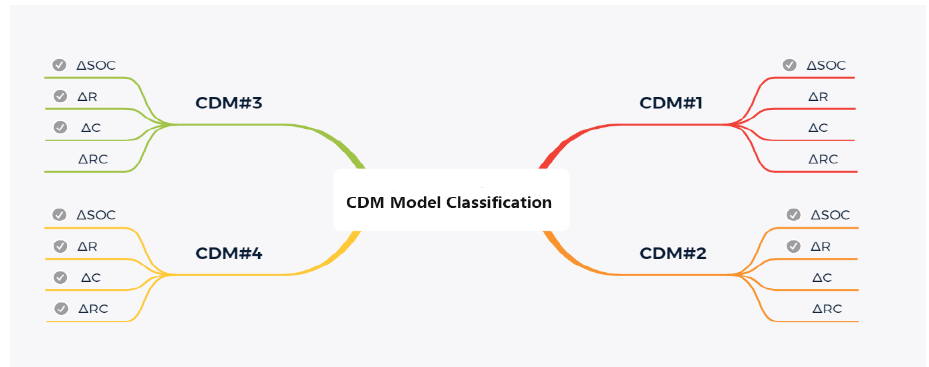
Figure 2. CDM model classification. Figure 2. CDM model